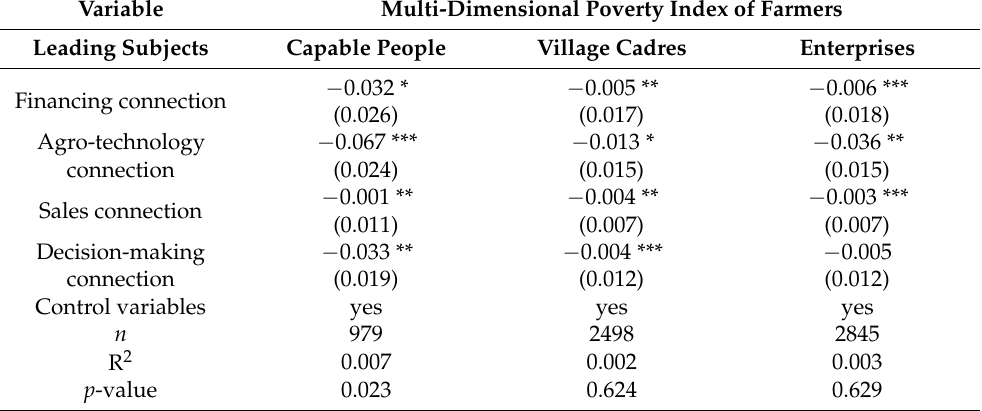
Table 8. Multidimensional poverty reduction effect of benefit coupling: heterogeneity of leading